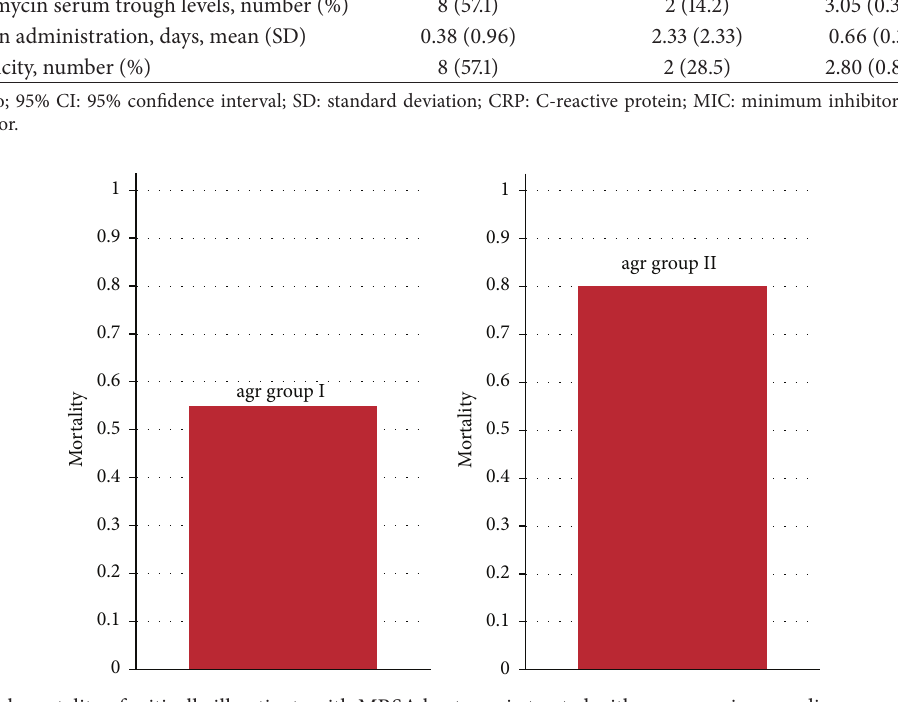
Figure 2: In-hospital mortality of critically ill patients with MRSA bacteremia treated with vancomycin according accessory gene regulator ( agr ) polymorphism. Values expressed as deaths/survival cases.